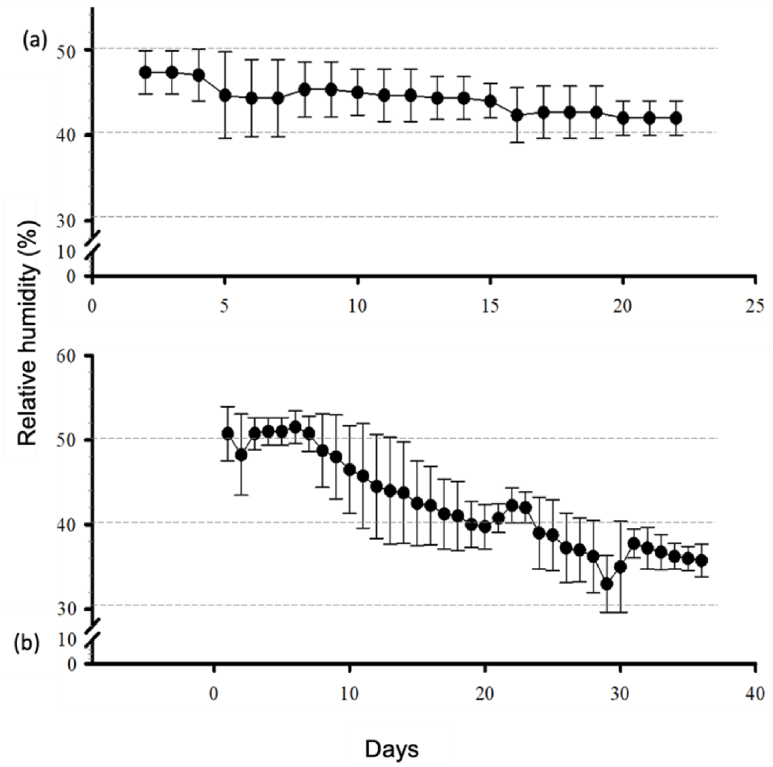
Figure 2. Daily behavior of the relative humidity percentage at the stabilization phase ( a ) and in the presence of 6 mL of collagen gel ( b ).